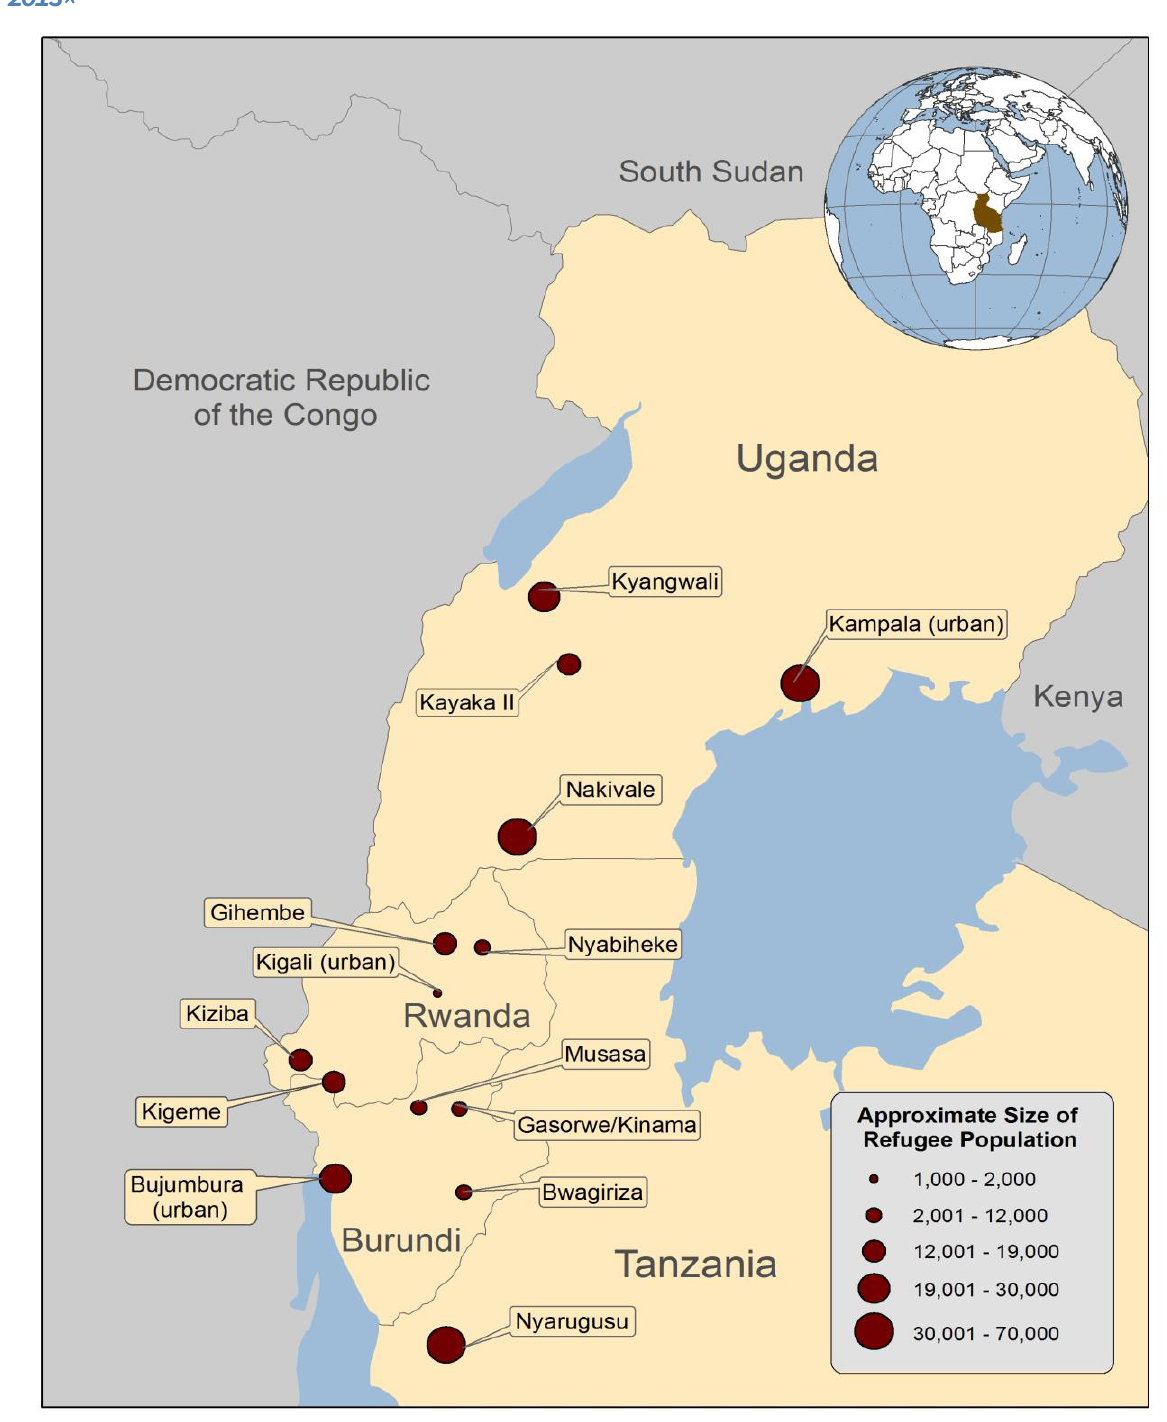
Figure 2. Location and size of major refugee populations in Burundi, Rwanda, Tanzania, and Uganda,